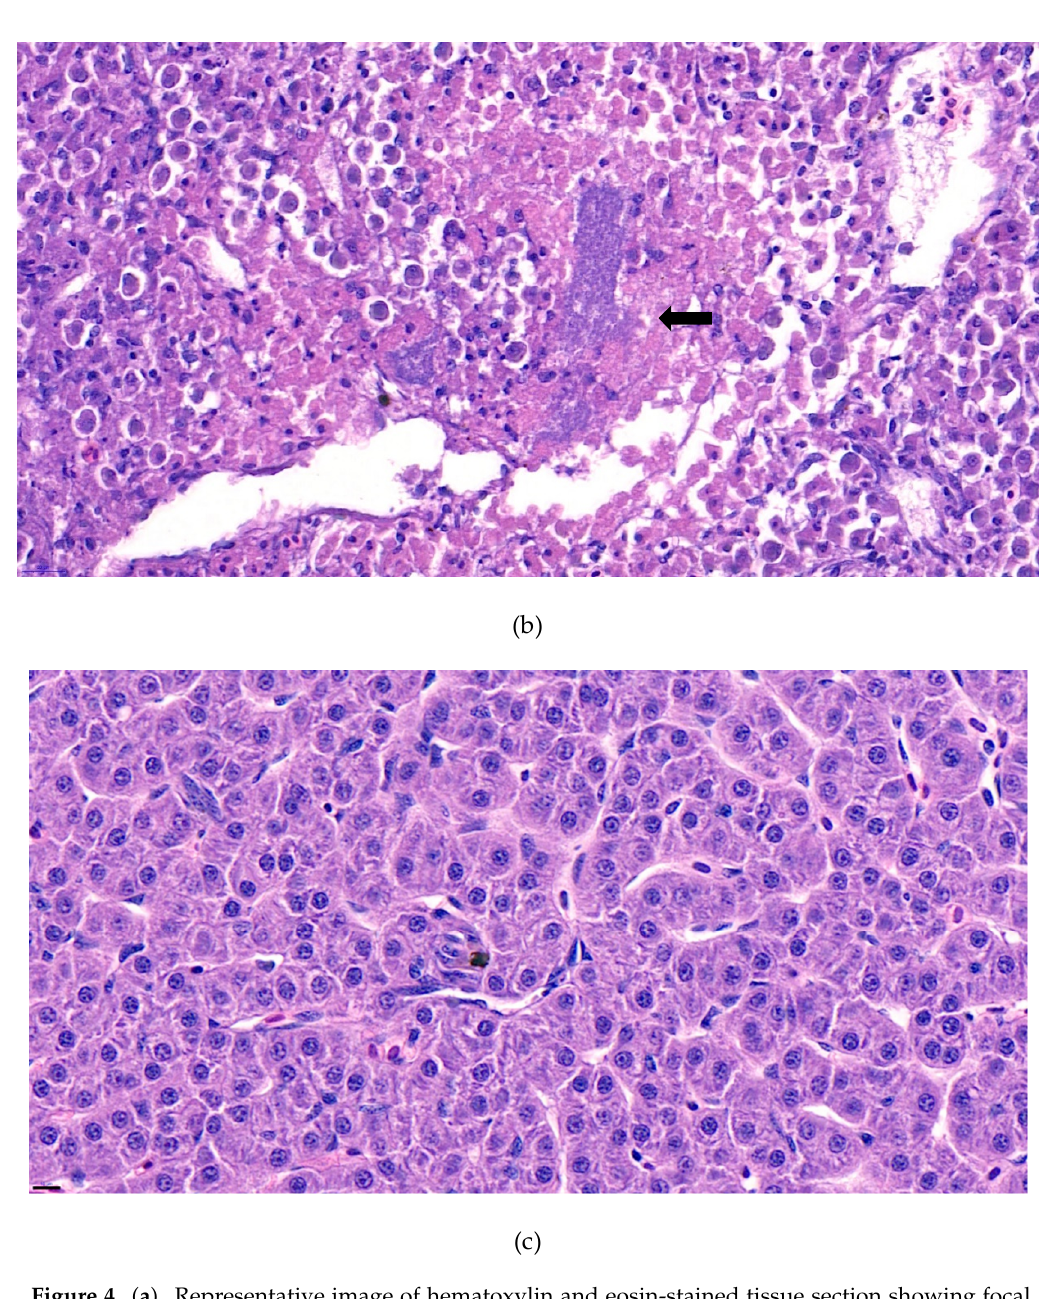
Figure 4. ( a ). Representative image of hematoxylin and eosin-stained tissue section showing focal necrotizing areas in the liver of the diseased fish. Cellular vacuolation can be observed around the lesion. (Bar indicating 10 µm). ( b ). Representative image of hematoxylin and eosin-stained tissue section showing infiltration of macrophages and lymphocytes with signs of bacteremia (arrow) in the liver of the diseased fish. 4 ( c ). Negative fish group liver image stained with hematoxylin and eosin. (Bar indicating 10 µm).